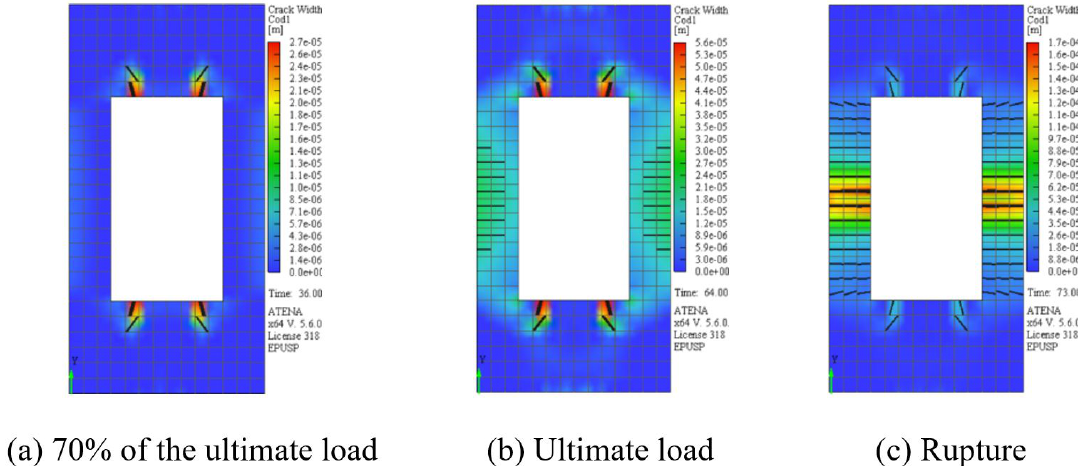
Figure 13. Crack pattern of model WO4a-C.